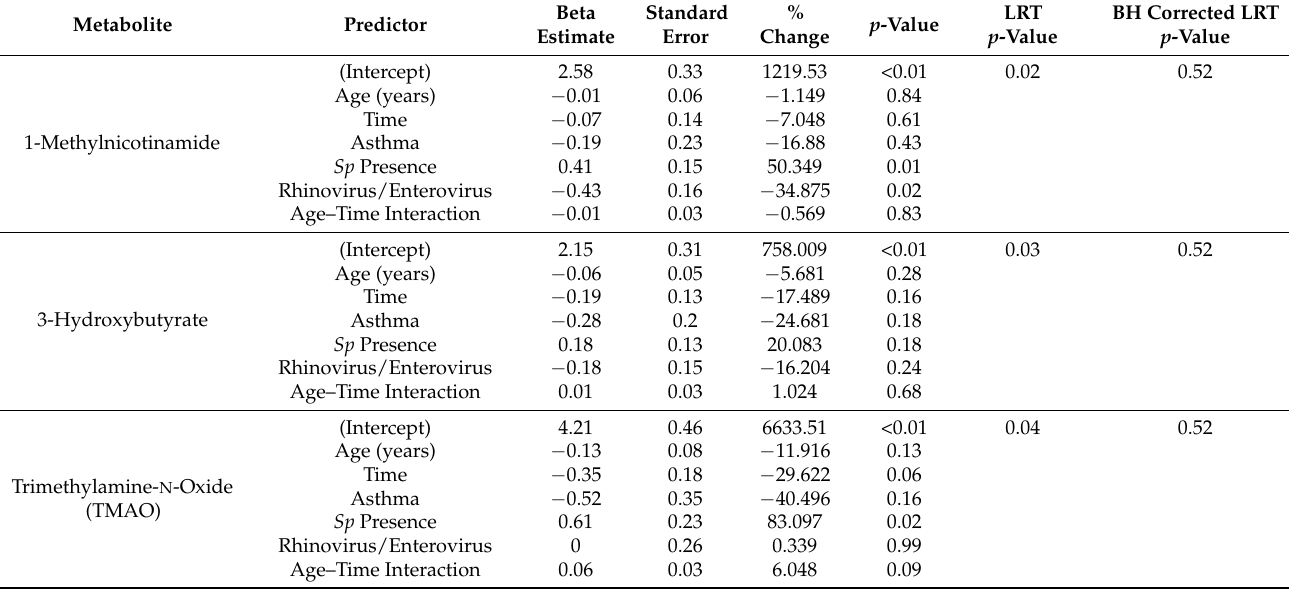
Table 2. Estimates from linear mixed models for each metabolite with a significant likelihood ratio test (LRT) comparing the full model to a null model with no covariates (global test). Metabolite levels were transformed on the log e scale to generate a normal distribution. Both unadjusted and BH-adjusted p -values for the LRT are shown. Independent variables in the full model included age, time, asthma diagnosis, Sp presence, viruses, age–time interaction term, and a random effect for subject and time within